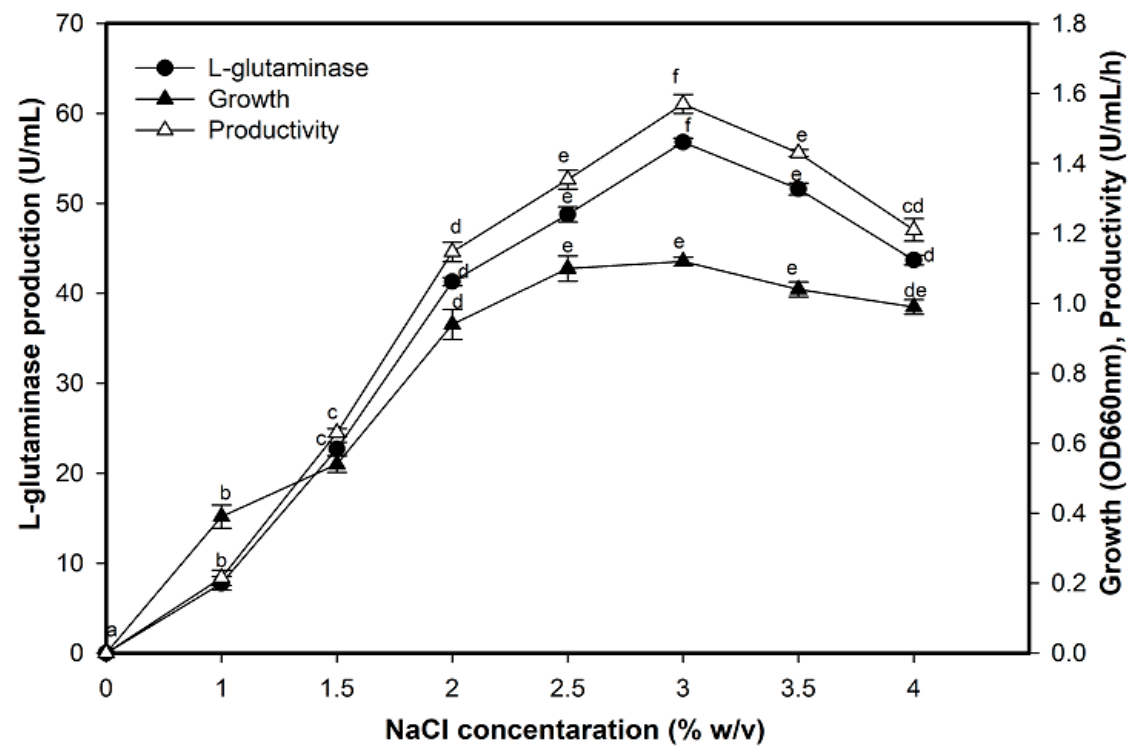
Figure 6. Effect of NaCl concentration ( w / v ) on L-glutaminase production. Mean ± standard error ( n = 3) is presented. Vertical bars indicate the standard errors of the means. Means followed by different letters are significantly different at p < 0.05.